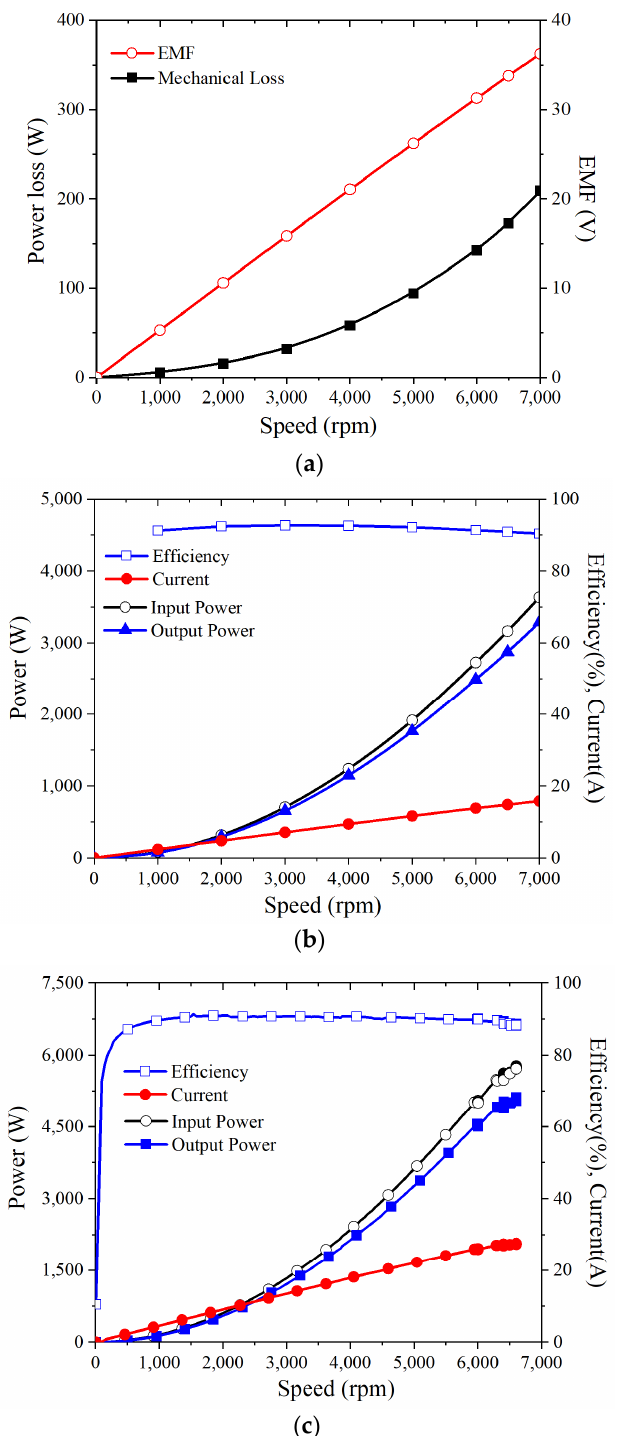
Figure 14. No-load and load test results according to speed and load resistance: (a) No-load test; (b) 2-ohm/phase resistance load test; and (c) 1-ohm/phase resistance load test.